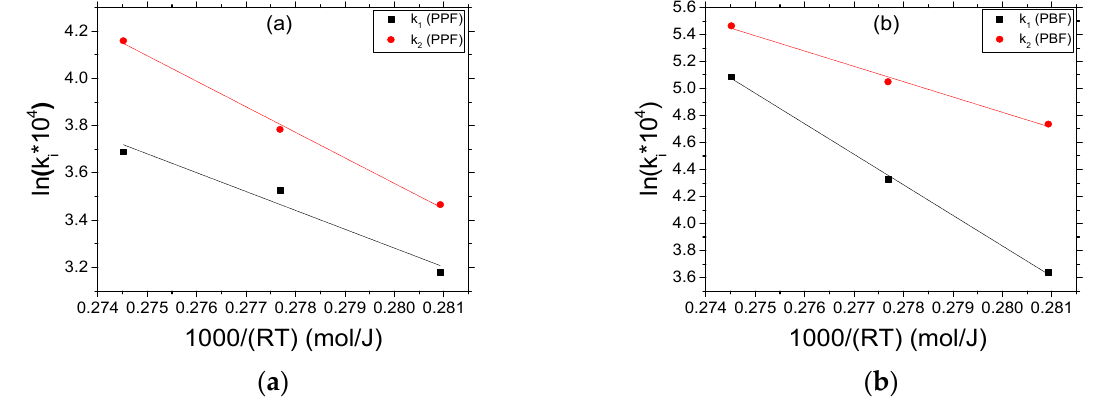
Figure 7. Arrhenius type plots in order to determine the activation energies and the pre-exponential factors of the polycondensation / transesterification (k 1 ) and esterification (k 2 ) reactions of PPF ( a ) and PBF ( b ) polyesters. Table 3. Activation energies, pre-exponential factors and correlation coefficients of the polycondensation / transesterification and esterification reactions of PPF and PBF polyesters.